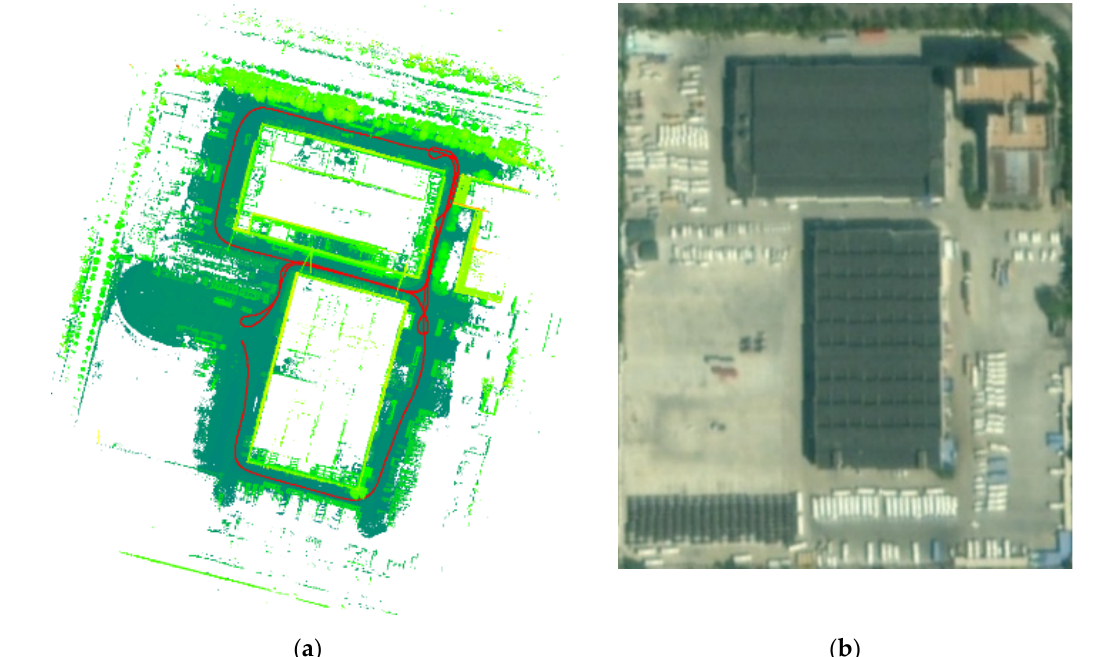
Figure 4. Test environment of industrial park. ( a ) is point cloud maps of industrial park, the red line indicates the test route; ( b ) is the experimental site environments.